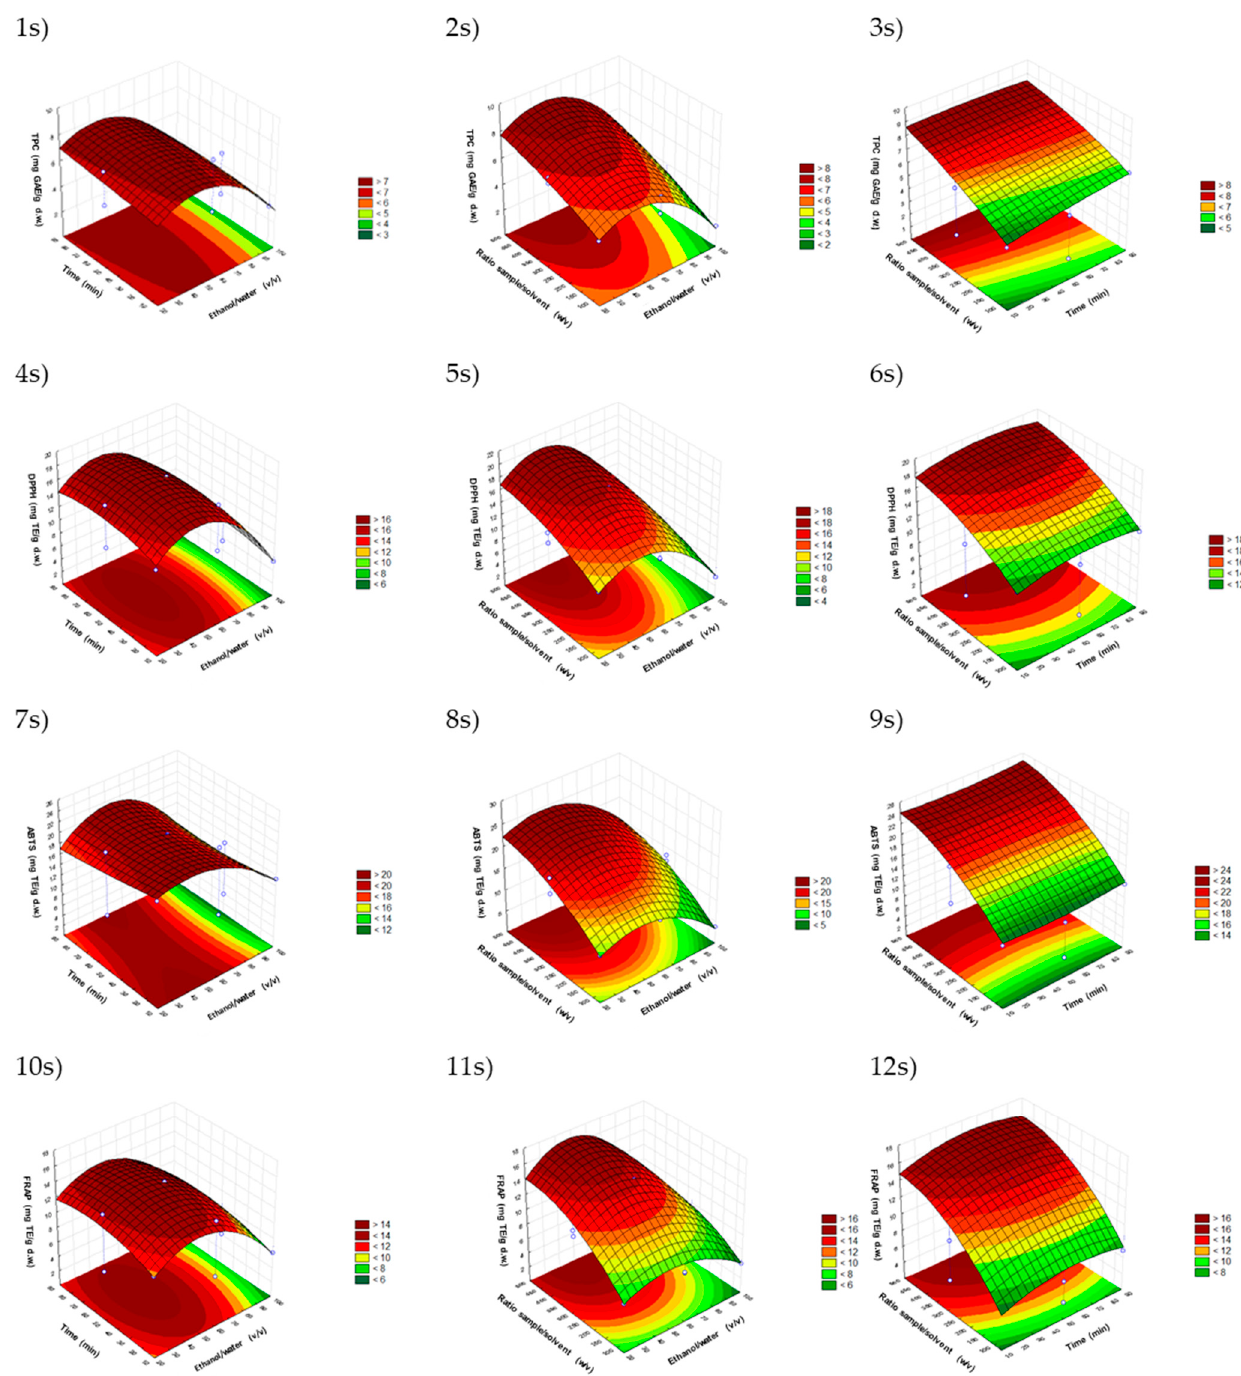
Figure 1. Response surface graphs (1s–12s) of ultrasonic bath model showing the combined effects of the process variables: ethanol/water ( v/v ), time (min), and ratio sample/solvent ( w/v ) for TPC (mg GAE/g dw), for DPPH antioxidant assay (mg TE/g dw), for ABTS antioxidant assay (mg TE/g dw), and for FRAP antioxidant assay (mg TE/g dw).